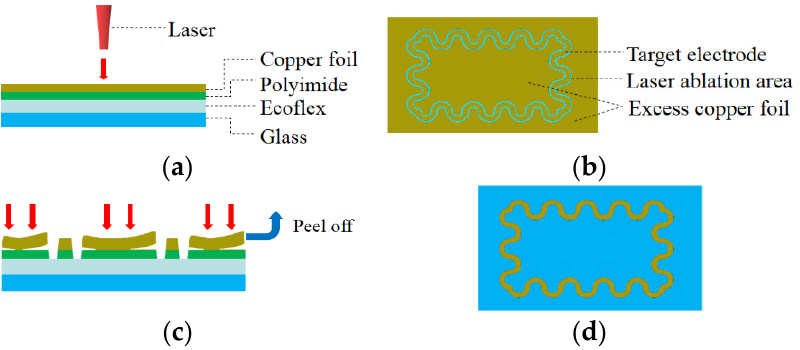
Figure 2. Stretchable electrode preparation process. ( a ) Fabrication of stretchable circuits; ( b ) laser cutting path; ( c ) laser irradiation causes the edges of the excess electrodes to deform to facilitate peeling; ( d ) target electrode is preserved.